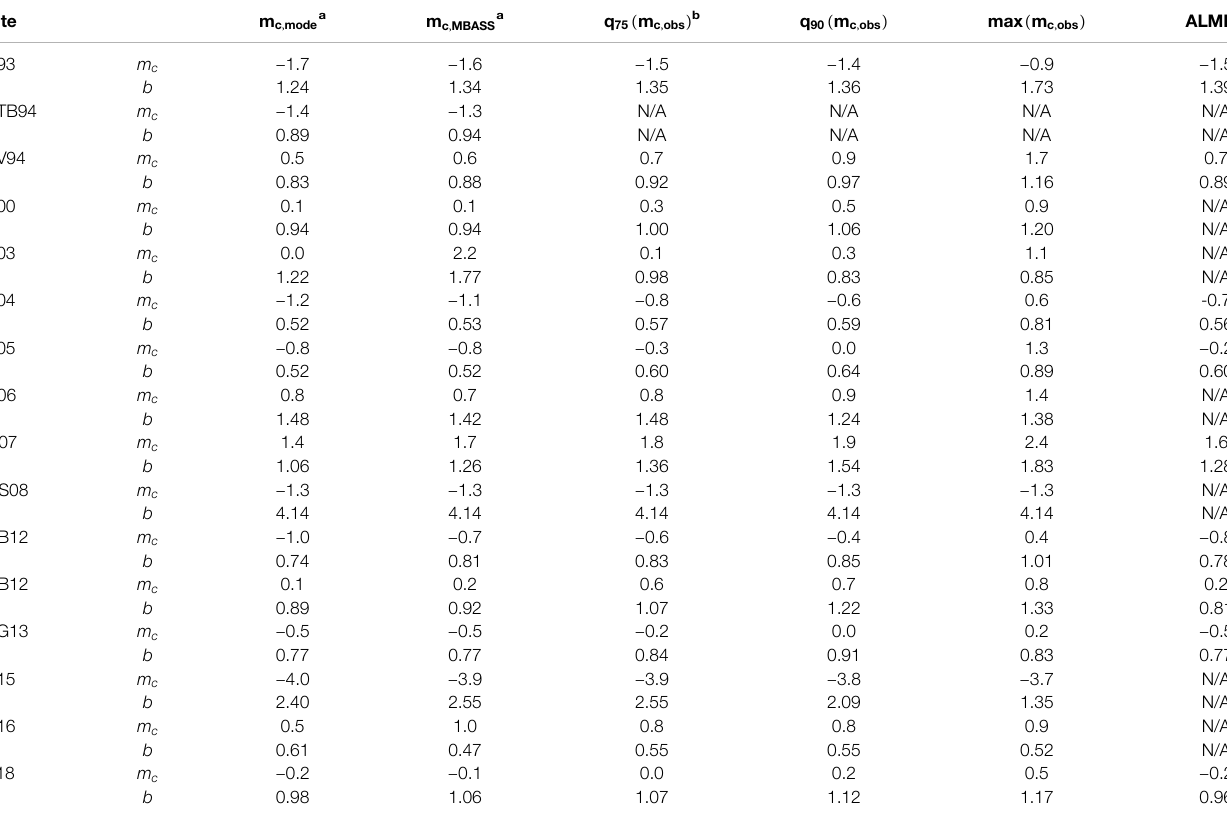
TABLE 2 | Parameters m c and b ( m c ) for different m c estimation methods applied to the bulk MFD.